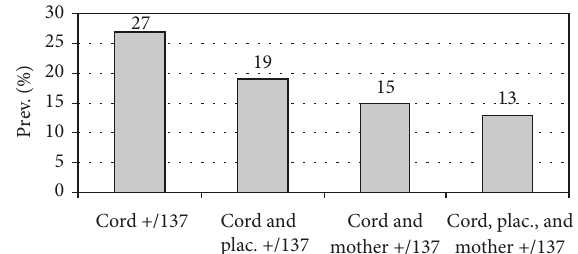
Figure 1: Prevalence of plasmodial infection in 137 cord-placenta- mother triplets, according to